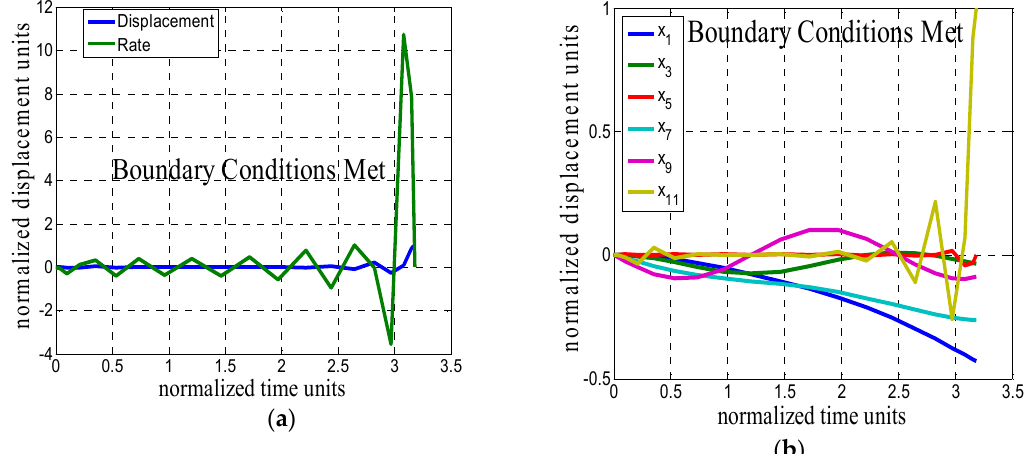
Figure 4. Scaled and unscaled plots of normalized states and tip displacement (calculated optimal cost = 3.1869). ( a ) Flexible spacecraft simulator (FSS) optimal extremal tip displacement and rate; ( b ) flexible spacecraft simulator (FSS) optimal states (node displacement